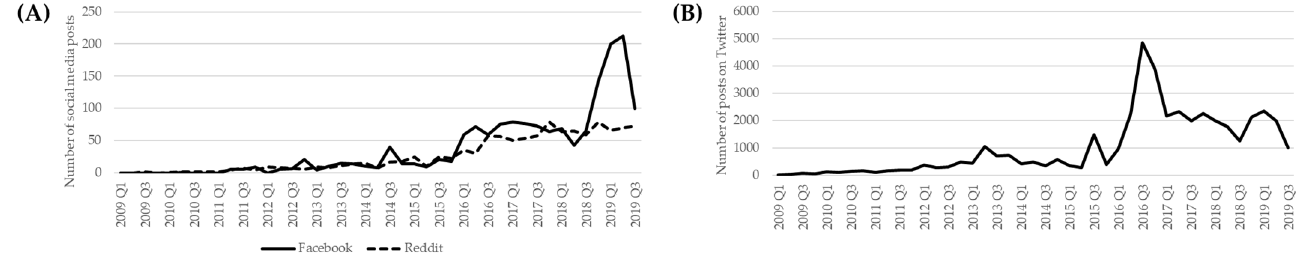
Figure 2. ( A ) Number of Facebook and Reddit posts mentioning the opioid crisis and/or opioid- related harms on Facebook (n = 1619) and Reddit (n = 1132) between 2009 and 2019; ( B ) Number of posts mentioning the opioid crisis and/or opioid-related harms on Twitter (n = 43,058) between 2009 and 2019.